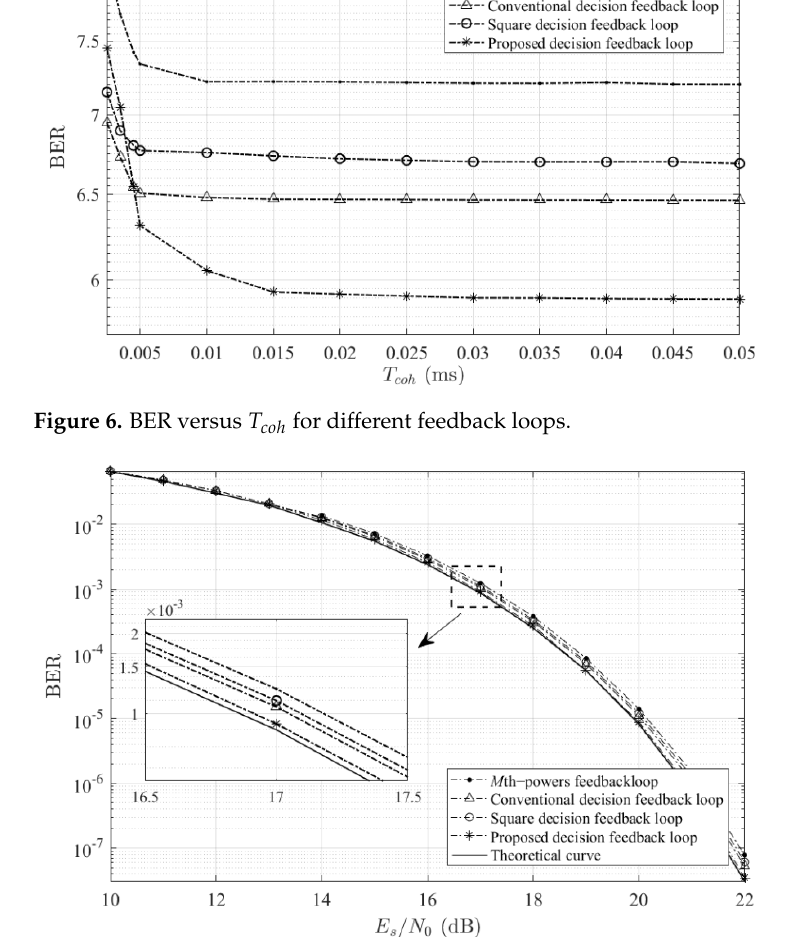
Figure 7. BER versus SNR for different feedback loops.